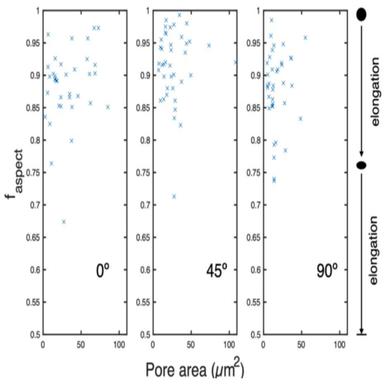
Pore aspect ratios as a function of pore area in the 0◦, 45◦ and 90◦ orientation.